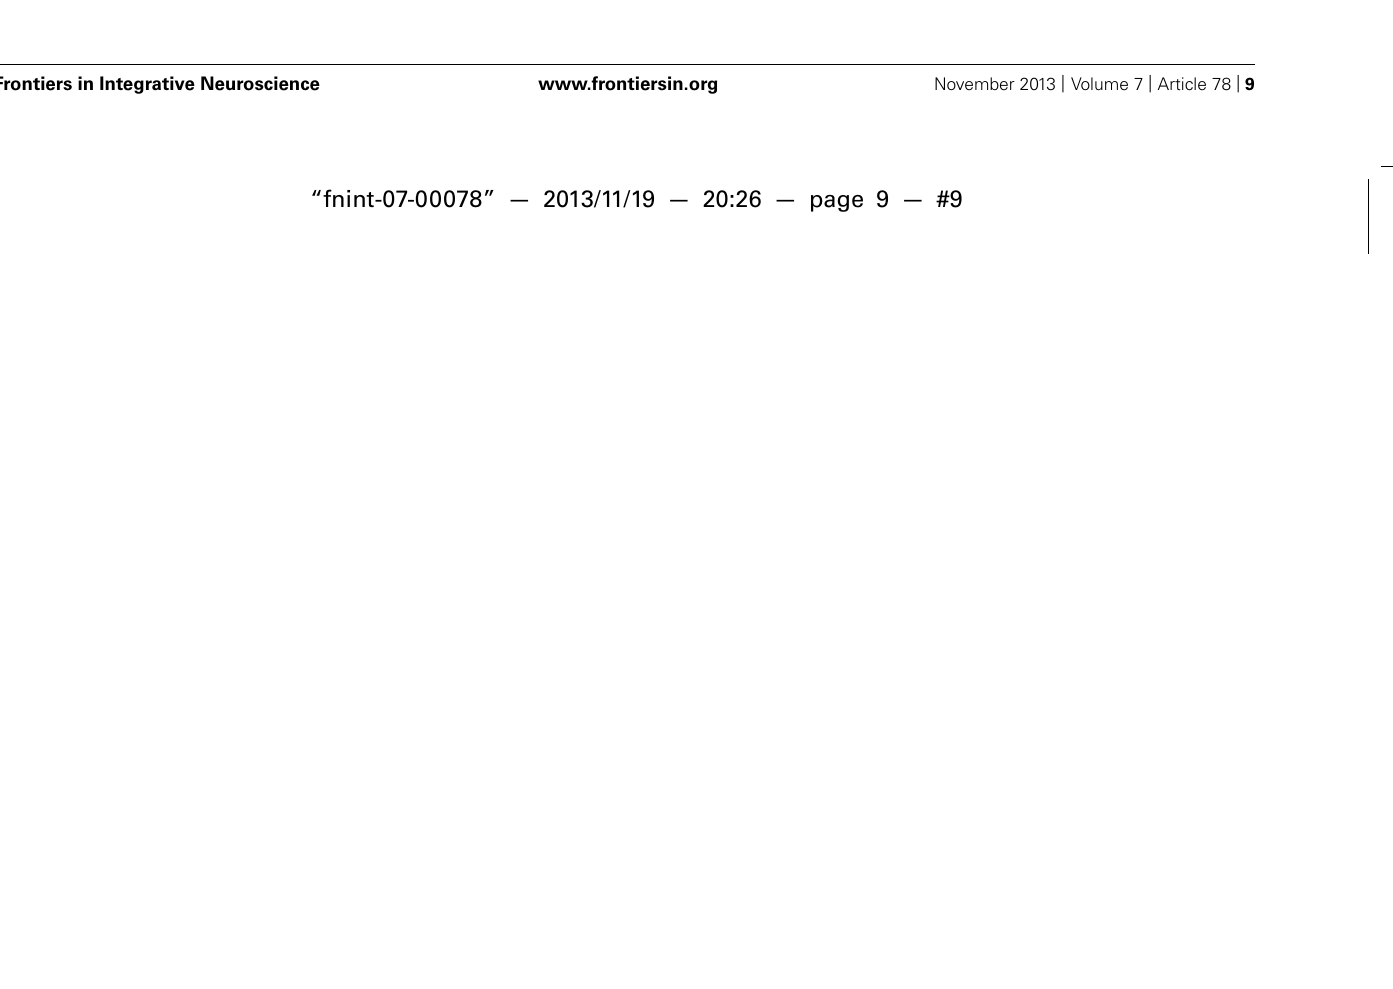
FIGURE 5 | Stag Hunt game environment. The game board included a 5 × 5 grid of spaces upon which the player (stick figure image), agent (robot image), stag (stag image), and hare (hare image) tokens resided. The screen included a button to start the experiment, the subject’s score for the round, the subject’s overall score for the experiment, the game